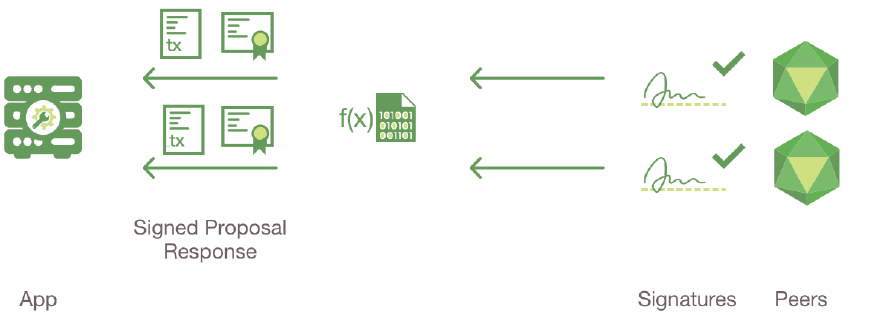
Figure 6. Proposed structure and flow of transactions through our proposed